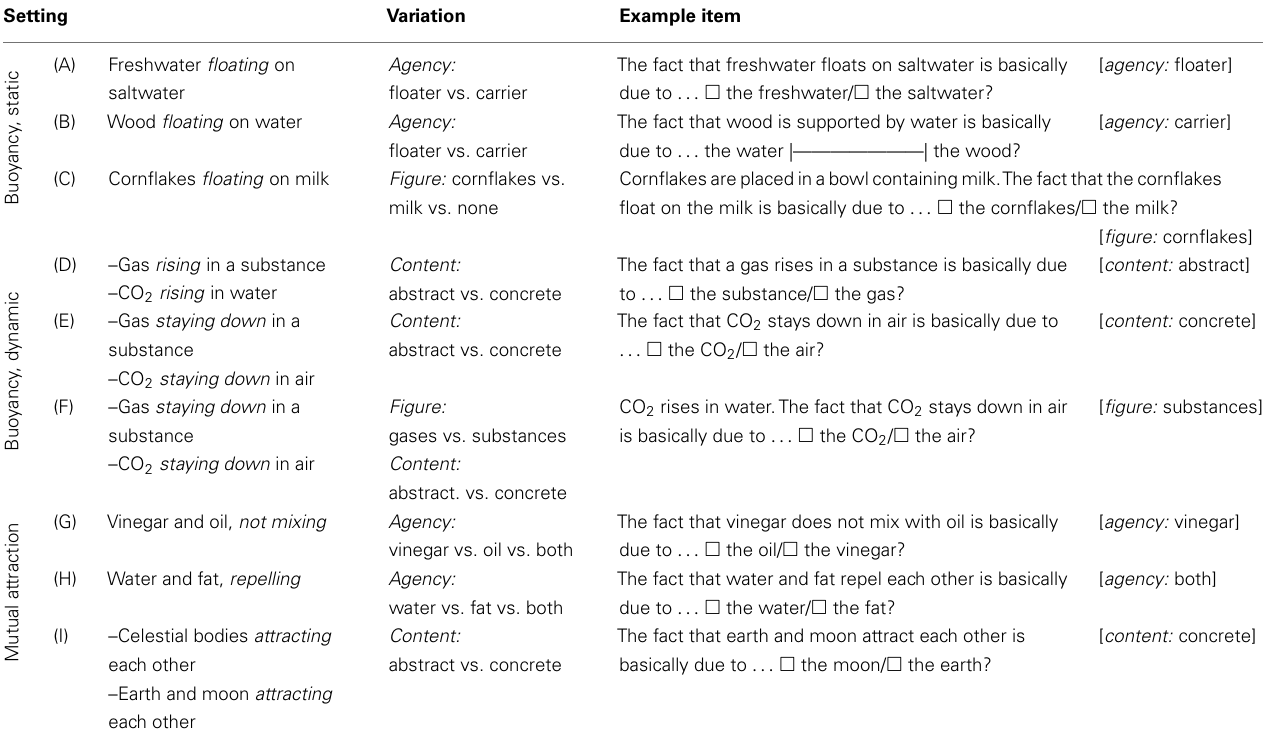
Table 1 |The nine physical settings, the experimental variation under scrutiny, and one example item. Setting Variation Example item